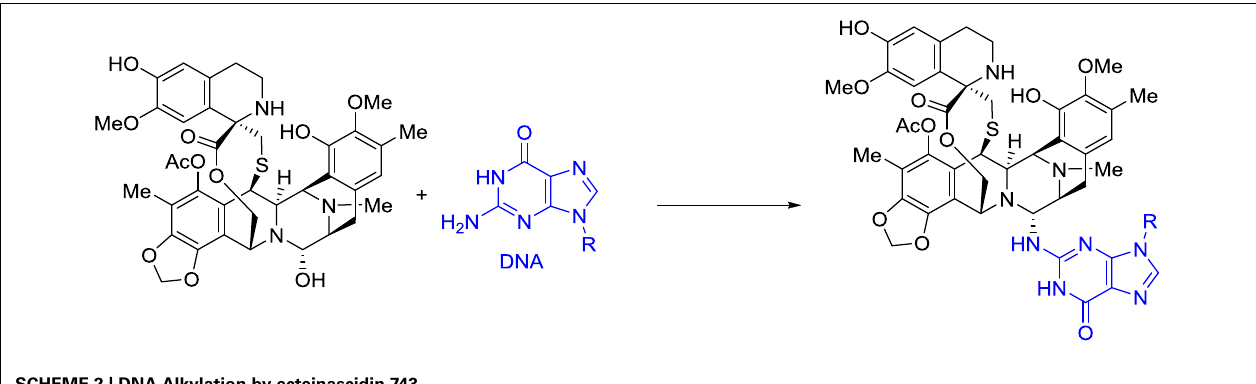
SCHEME 2 | DNA Alkylation by ecteinascidin